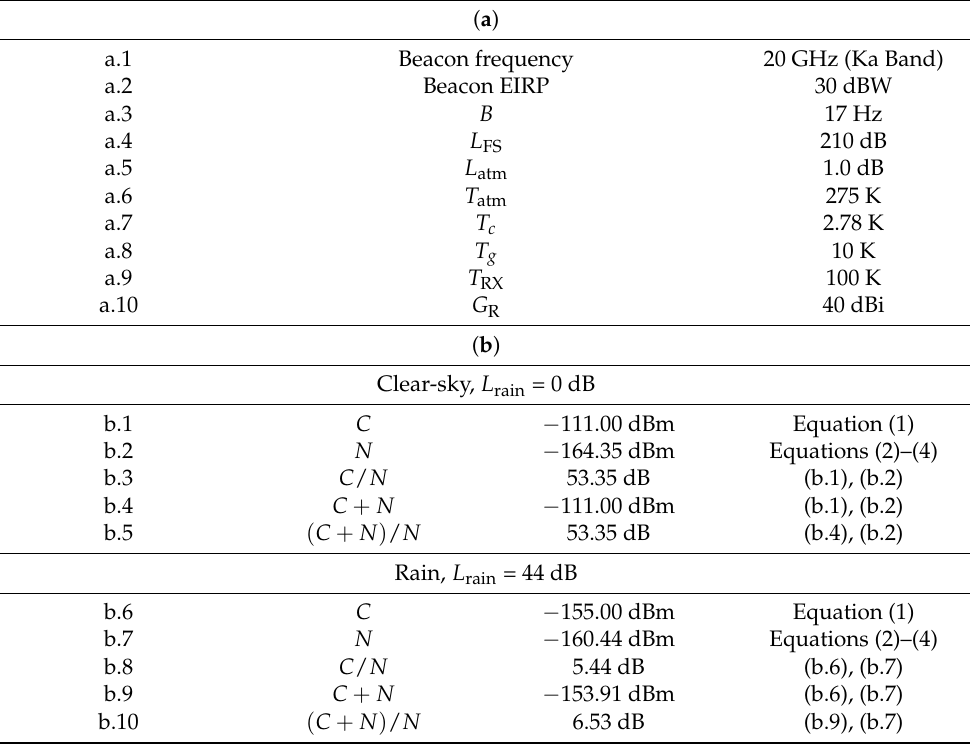
Table 4. Parameters of a beacon-receiving system using a Ka-band broadband satellite: ( a ) system specifications (based on the numerical values used in [47]); ( b )